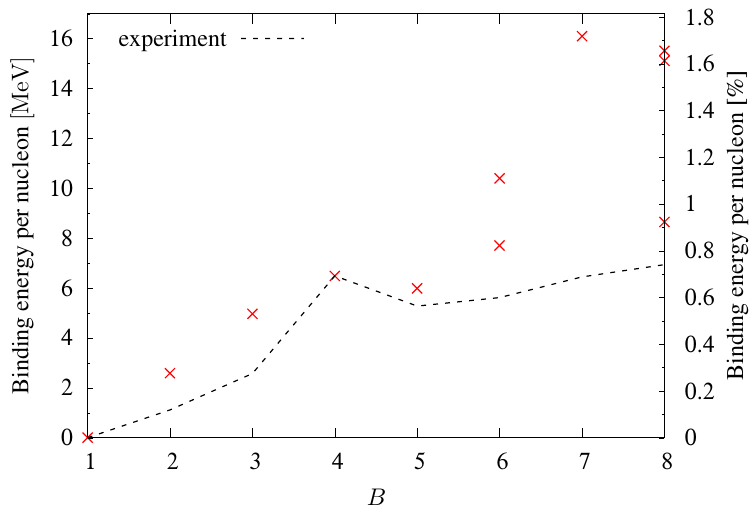
Figure 8 . The classical binding energies of the numerical multi-Skyrmion solutions for the ((cid:12)rst) calibration point, compared with experimental data.